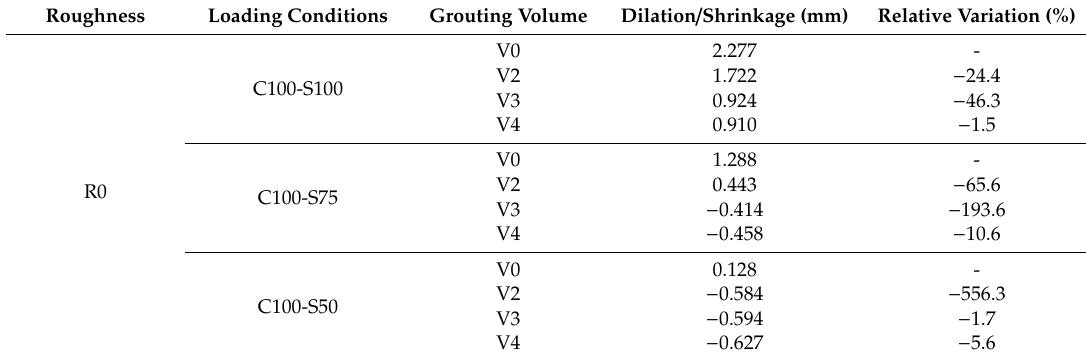
Table 7. Final dilation/shrinkage for specimens with R0 and different grouting volumes under unloading conditions